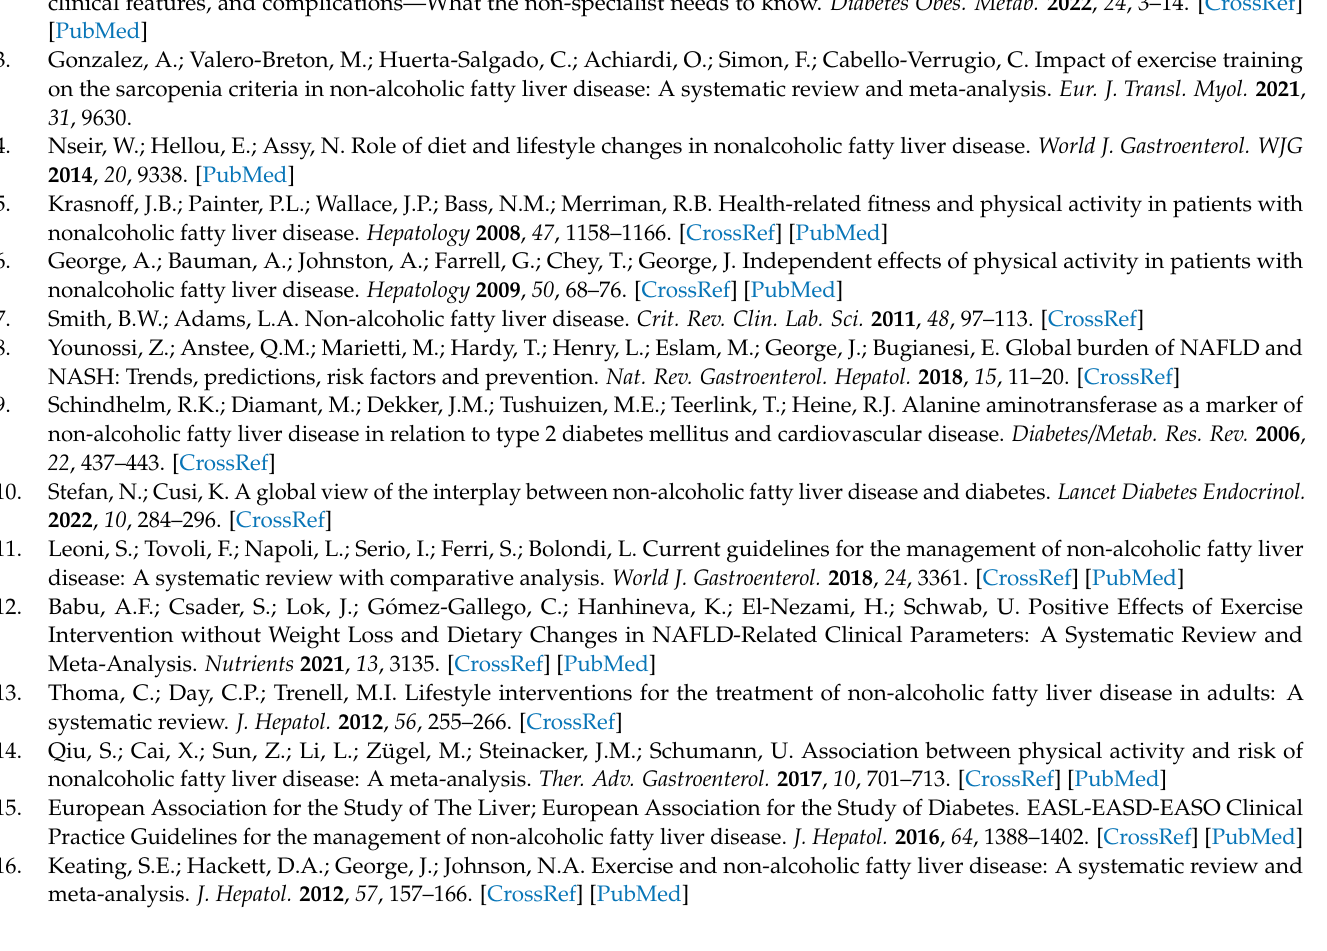
Figure S2: Funnel plot for AST levels; Figure S3: Funnel plot for FBG levels; Figure S4: Funnel plot for insulin; Figure S5: Funnel plot for HOMA-IR; Table S1: PRISMA Checklist; Table S2. Study quality assessment; Table S3: Search strategy